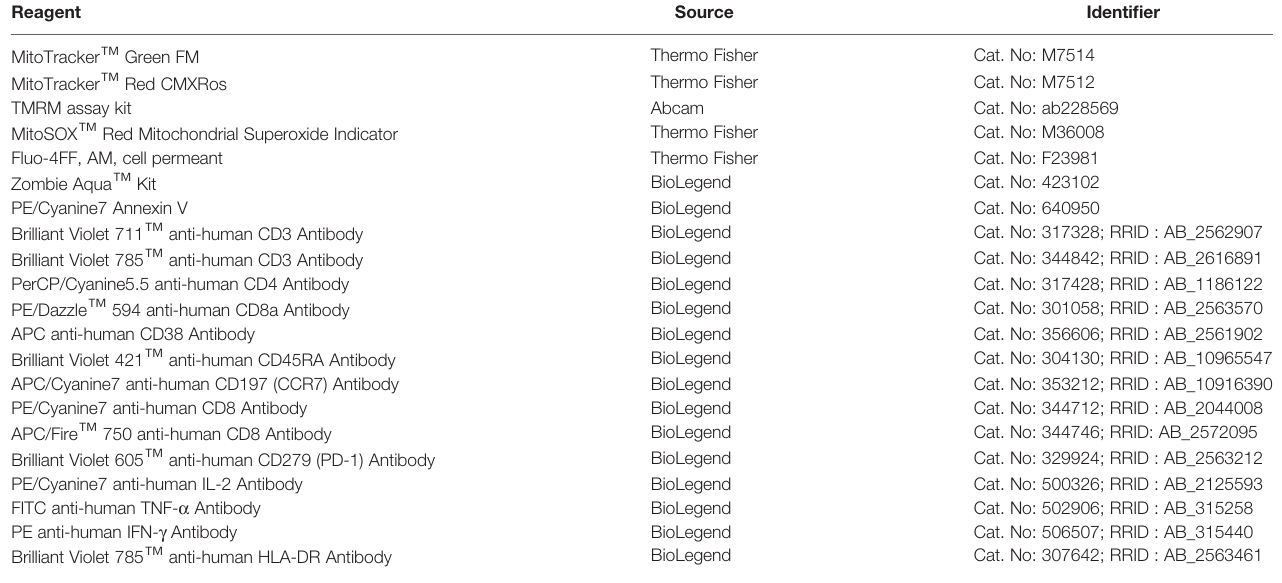
TABLE 2 | List of antibodies or reagents that were used for FACS analysis.